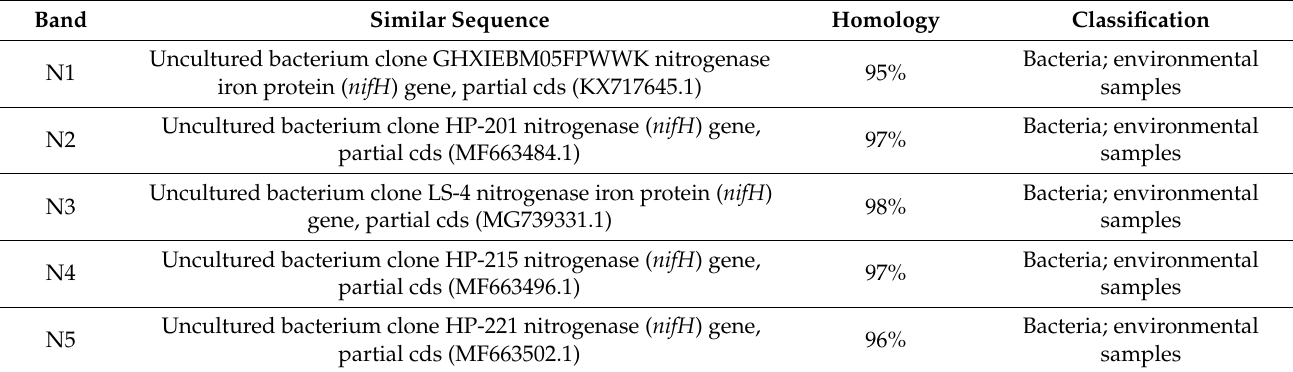
Table 4. Similarity sequence analysis of nifH gene N1-N24 from